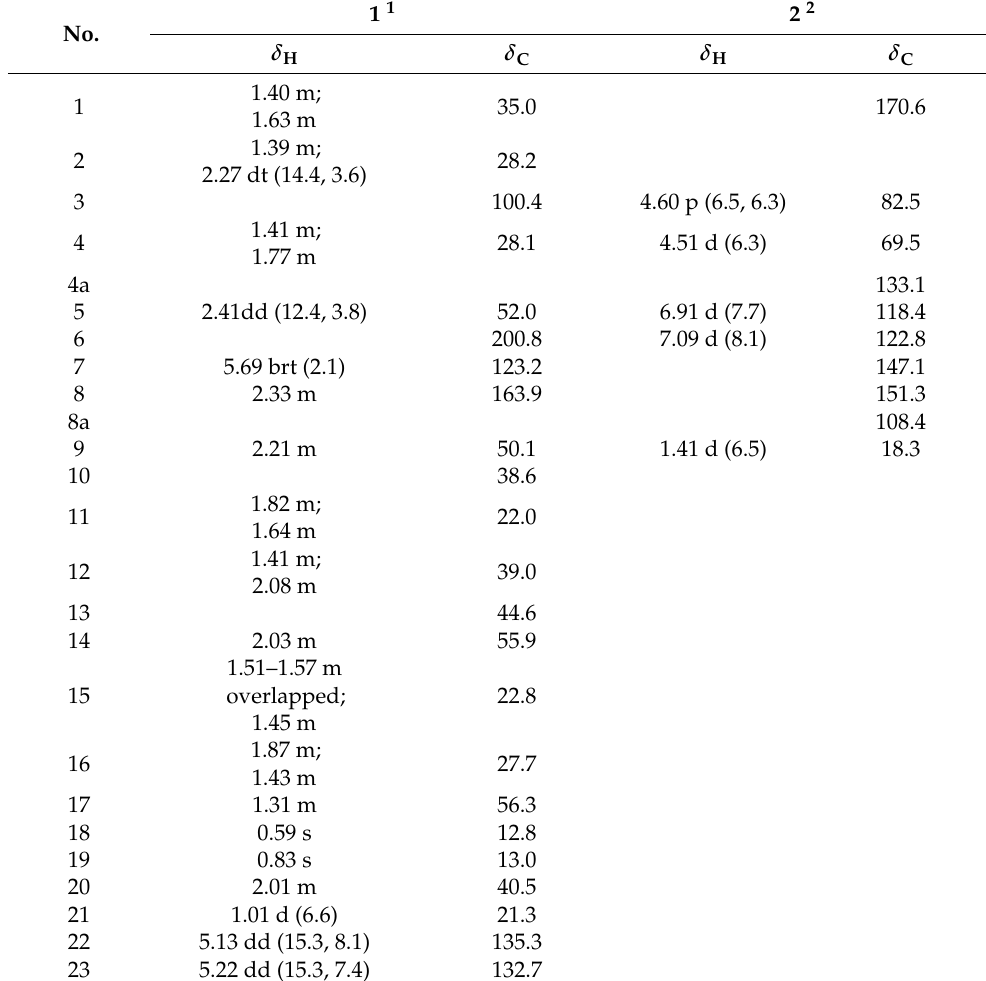
Table 1. 1H (400 MHz) and 13C (100 MHz) NMR data of compounds 1 and 2 ( δ in ppm, J in Hz). 1 No.